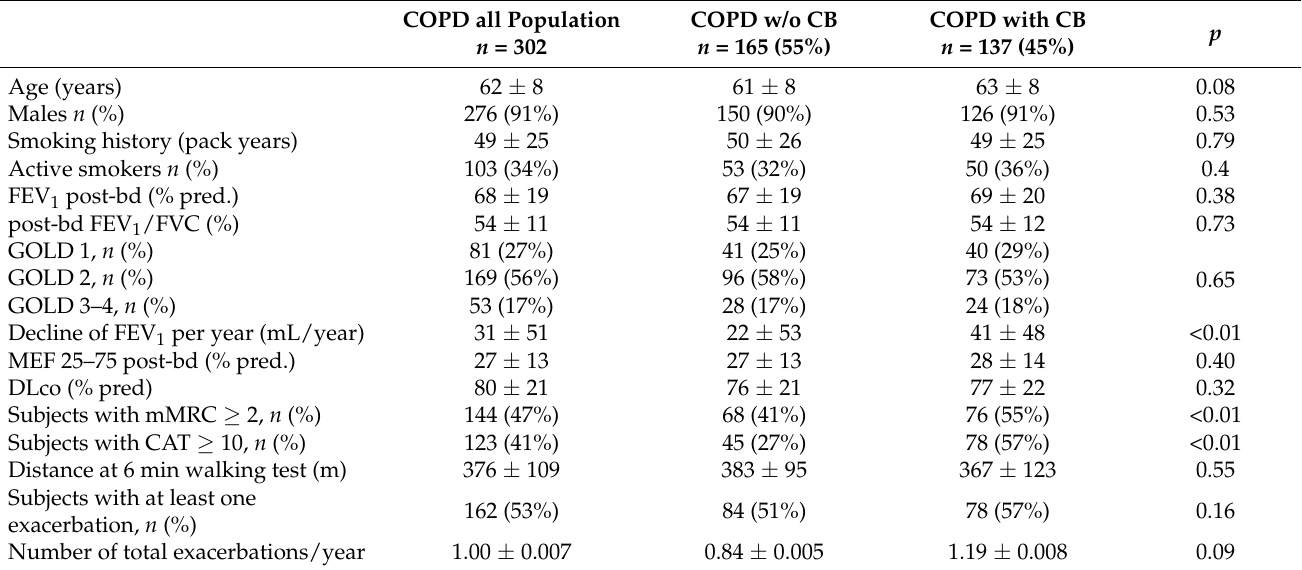
Table 2. Clinical characteristics of subjects with